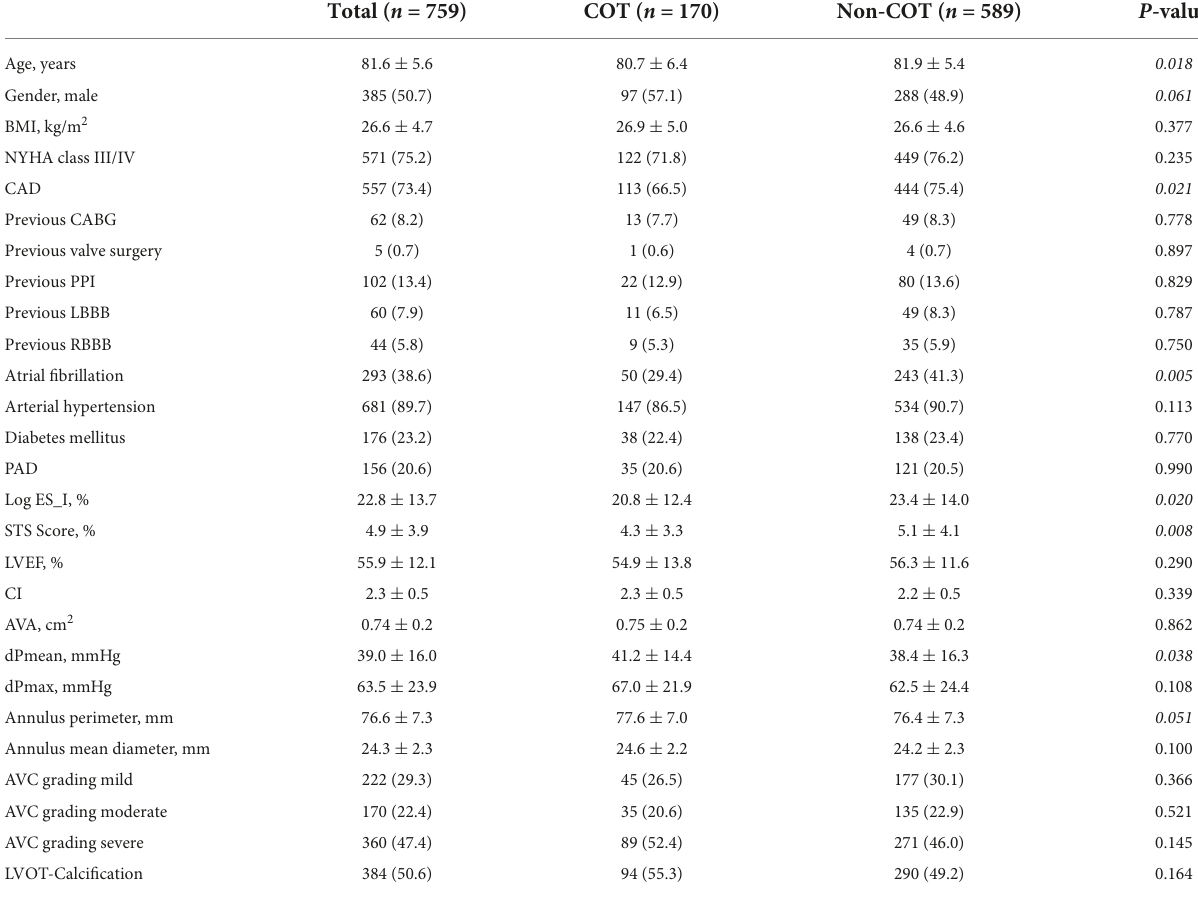
TABLE 1 Patient clinical and functional characteristics in unmatched